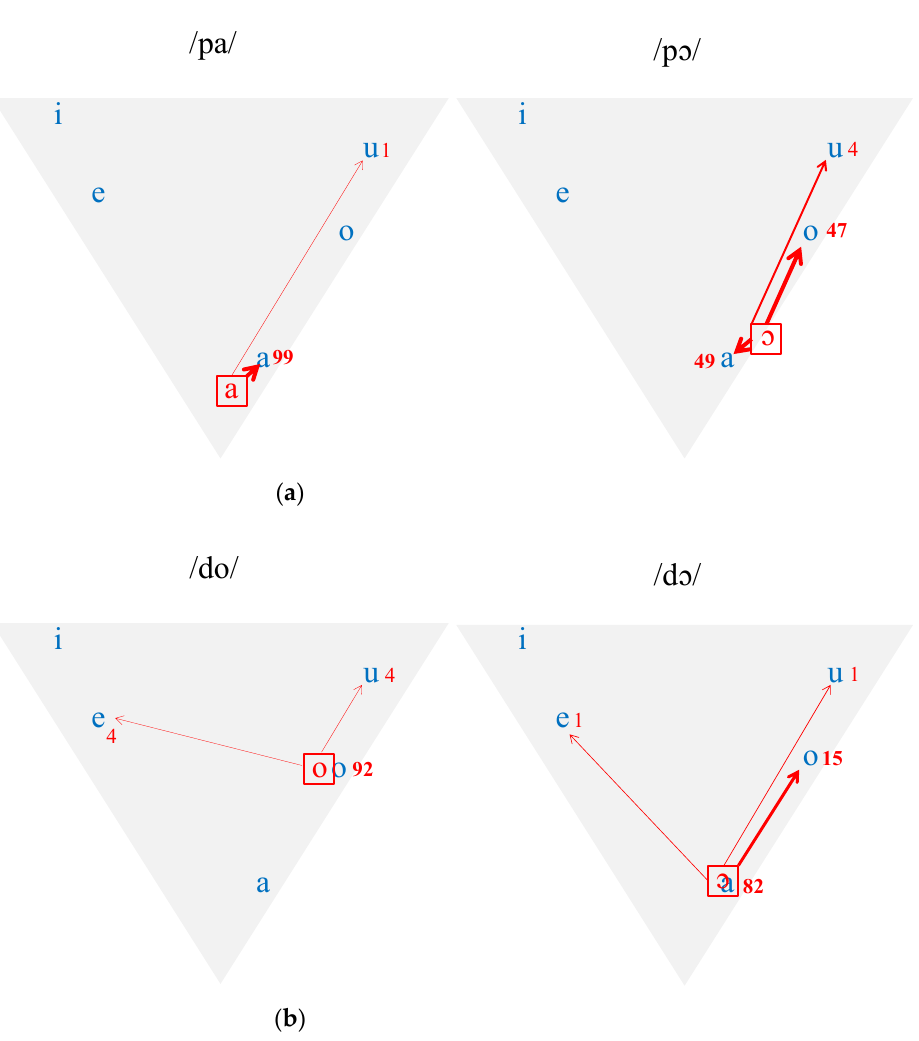
Figure 4. The percentage of Hñäñho words categorized as containing Spanish vowels by Mexican Spanish monolinguals (MSM): ( a ) the/a - ɔ /vowel contrast; ( b ) the/o - ɔ /vowel contrast. As shown in Figure 4, MSM categorized the Hñäñho vowel/ o /from the Hñäñho word/ do /almost exclusively as the Spanish vowel/ o /(92%), whereas most instances of the Hñäñho vowel/ ɔ /contained in the Hñäñho word/ dɔ /were categorized by MSM as the Spanish vowel/ a /(82%), followed by the Spanish vowel/ o /(15%). These results reveal sim- ilarities in the proportion of the Hñäñho vowel/ ɔ /categorized as the vowels/ a /and/ o /for